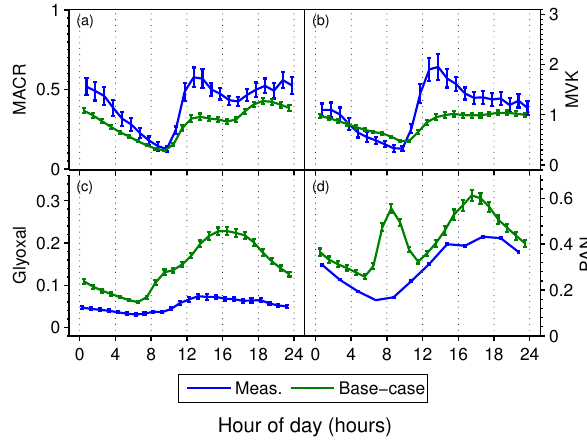
Fig. 7. Summary of model OVOCs and measurements as available, all in ppb. The model is broadly able to predict MVK and MACR, while it exceeds measurements of glyoxal substantially. The slight under-prediction of MVK and MACR is expected for the 0-D-box model as it underestimates the contribution of isoprene oxidation, which is largely emitted upwind of the measurement site. Error bars indicate the 1 standard deviation envelope as calculated based on the variability in the data, not reported errors.